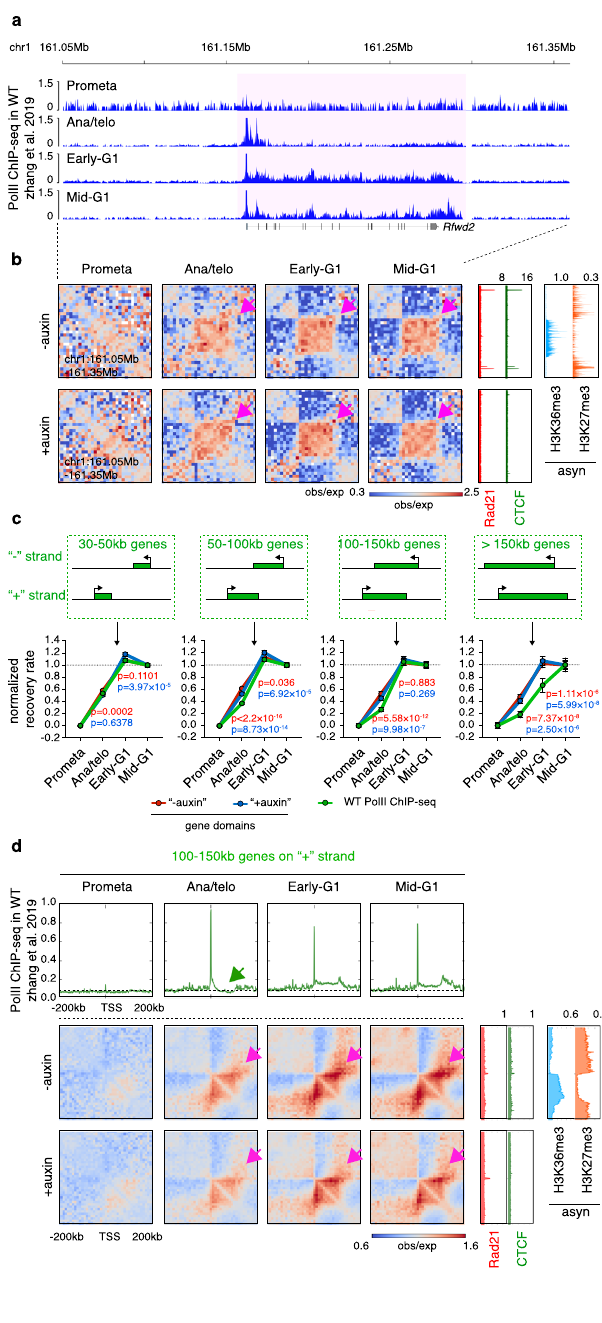
Fig. 5 Gene domains emerge prior to completion of the fi rst round of transcription after mitosis. a PolII ChIP-seq genome browser tracks at the Rfwd2 locus across cell cycle stages in parental cells. Note that in ana/ telophase PolII is detected at the promoter region but the initial round of transcription has not been completed. b KR balanced Hi-C contact matrices of the same region as in ( a ) across cell cycle stages in control and auxin- treated samples. Bin size: 10 kb. Purple arrows indicate the domain of the Rfwd2 gene in post-mitotic stages. Tracks of CTCF and Rad21 with or without auxin treatment as well as histone marks H3K36me3 and H27me3 are from asynchronously growing G1E-ER4 cells. c Upper panel: Schematic of genes with different sizes. Lower panel: Line graphs of recovery rates of gene domains in the control and auxin-treated samples and the recovery rate of PolII occupancy over the gene body. Genes corresponding to the size ranges in the upper panel were separately plotted. n = 952, 846, 260, and 119 genes with size ranges of 30 – 50, 50 – 100, 100 – 150 kb, and over 150 kb, respectively. P values were calculated using a two-sided paired Wilcoxon signed-rank test. Red and blue asterisks represent comparisons between PolII and gene domains in untreated control or auxin-treated samples, respectively. Error bars denote SEM. d Upper panel: Meta-region pile-up plots of PolII ChIP-seq signals corresponding to the 100 – 150kb genes on the plus strand across cell cycle stages. Plots are centered on TSS. Lower panel: Pile-up Hi-C matrices showing the domains of the genes corresponding to the upper panel across cell cycle stages in untreated and auxin treated samples. Bin size: 10 kb. Plots are centered on TSS. Gene domains are labeled with purple arrows. Meta-region plots of CTCF and Rad21 with or without auxin treatment, as well as H3K36me3 and H3K27me3, are shown on the